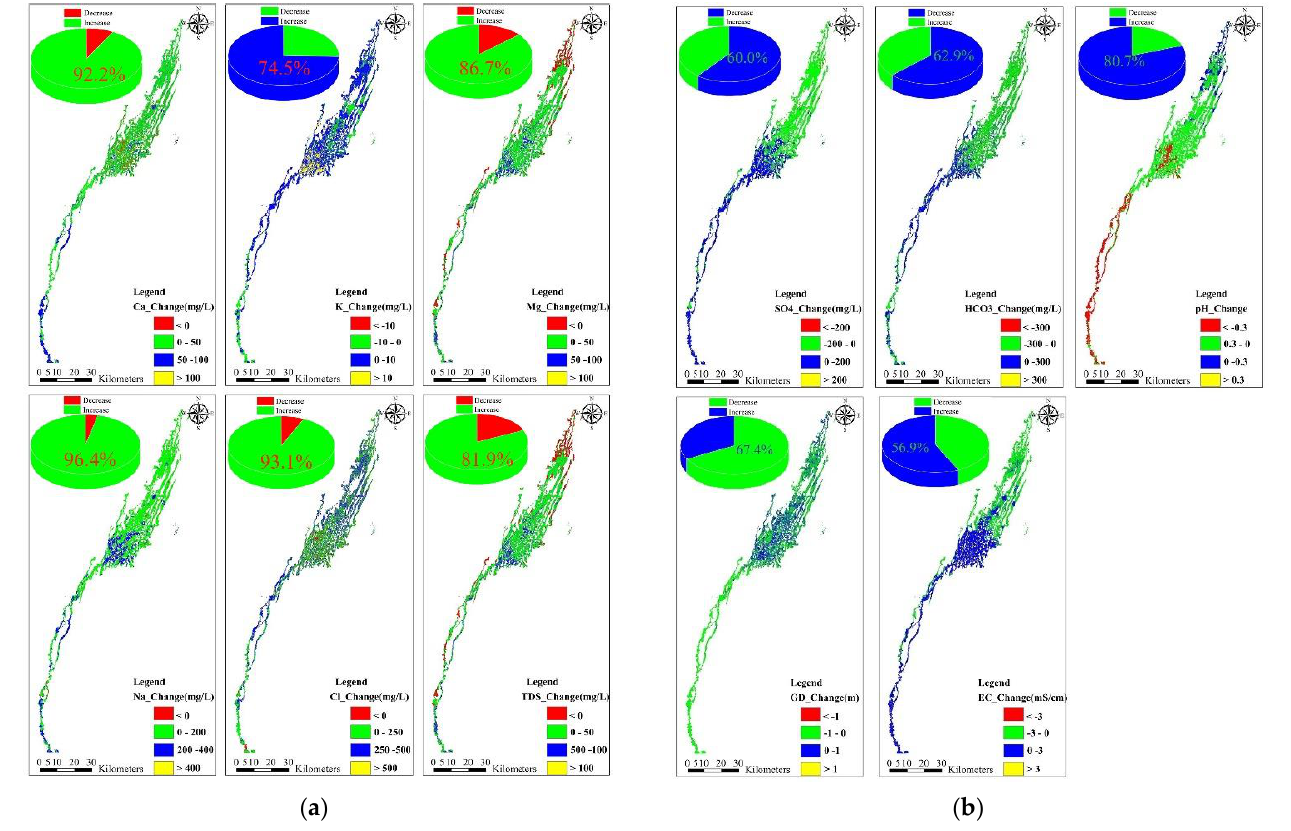
Figure 3. Changes in groundwater parameters pre-flood (PRF) and post-flood (POF) from remote sensing inversion results. ( a ) Content of groundwater water chemical parameters is increased. ( b ) GD and EC are increased and the content of groundwater water chemical parameters is decreased.